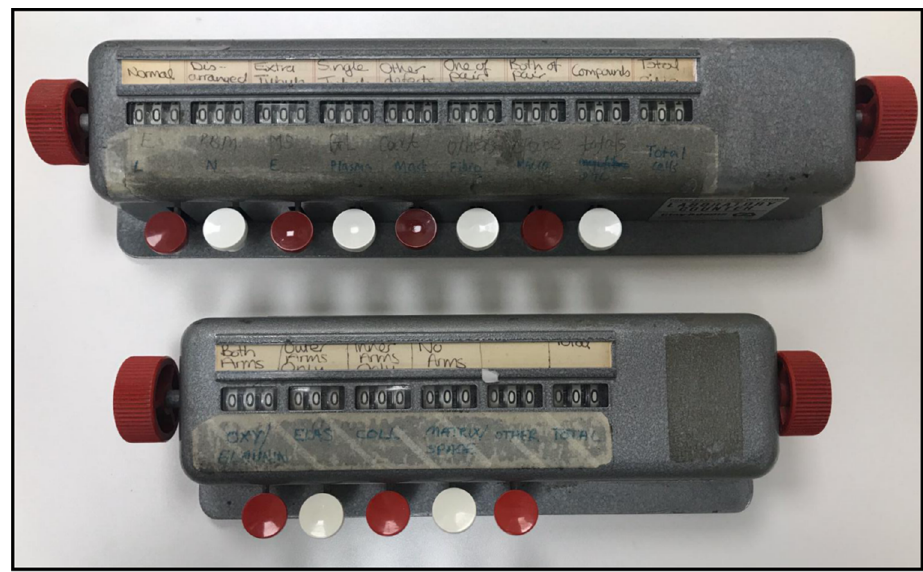
Figure 3. Physical counters used to count cilia features to assist in the diagnosis of PCD.